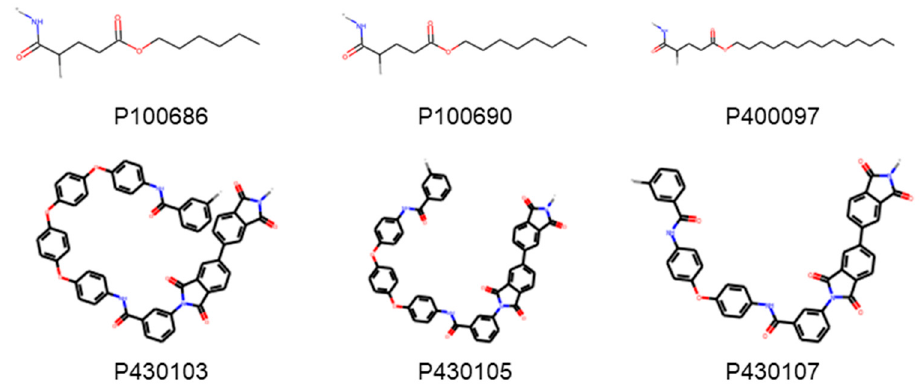
Figure 5 . Two examples of polymers that cannot be distinguish by ECFP2 and need ECFP 8 to distinguish. The first example is of alkanes with increasing chain length, while the second is of difference in repeating ring patterns.